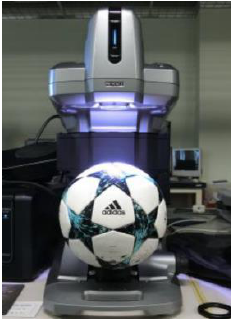
Figure 1. Groove shape measurement. Appl. Sci. 2020 , 10 , x FOR PEER REVIEW